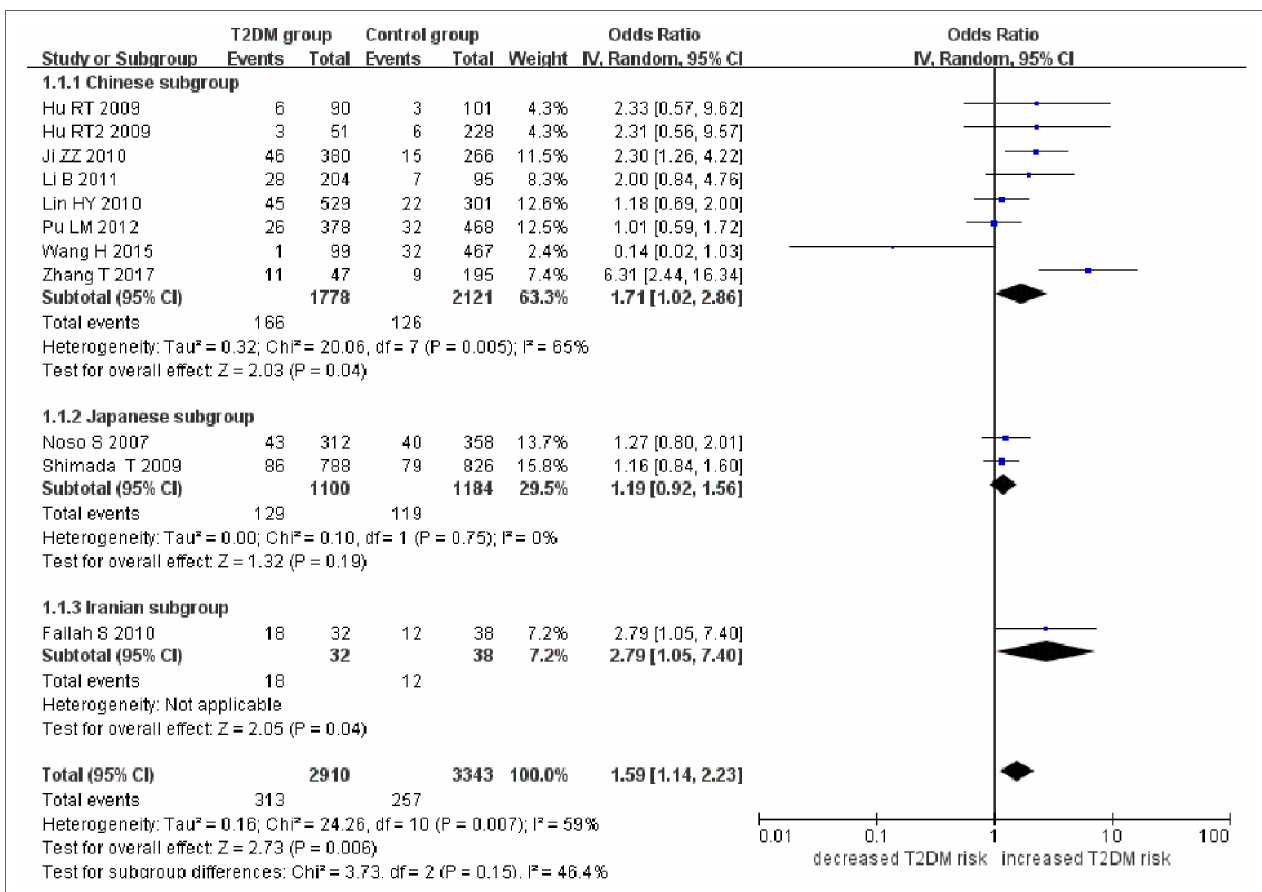
FigUre 2 | Forest plot of type 2 diabetes mellitus (T2DM) associated with small ubiquitin-like modifier 4 gene M55V polymorphism under a recessive genetic model (VV vs. MM +